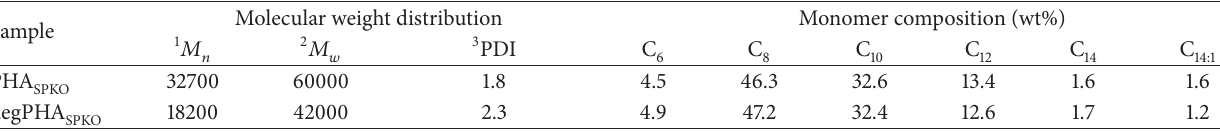
Table 1: Molecular weight distribution and monomer compositionsof PHA respectively.